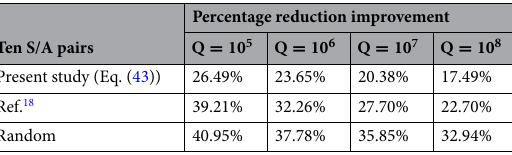
Percentage reduction